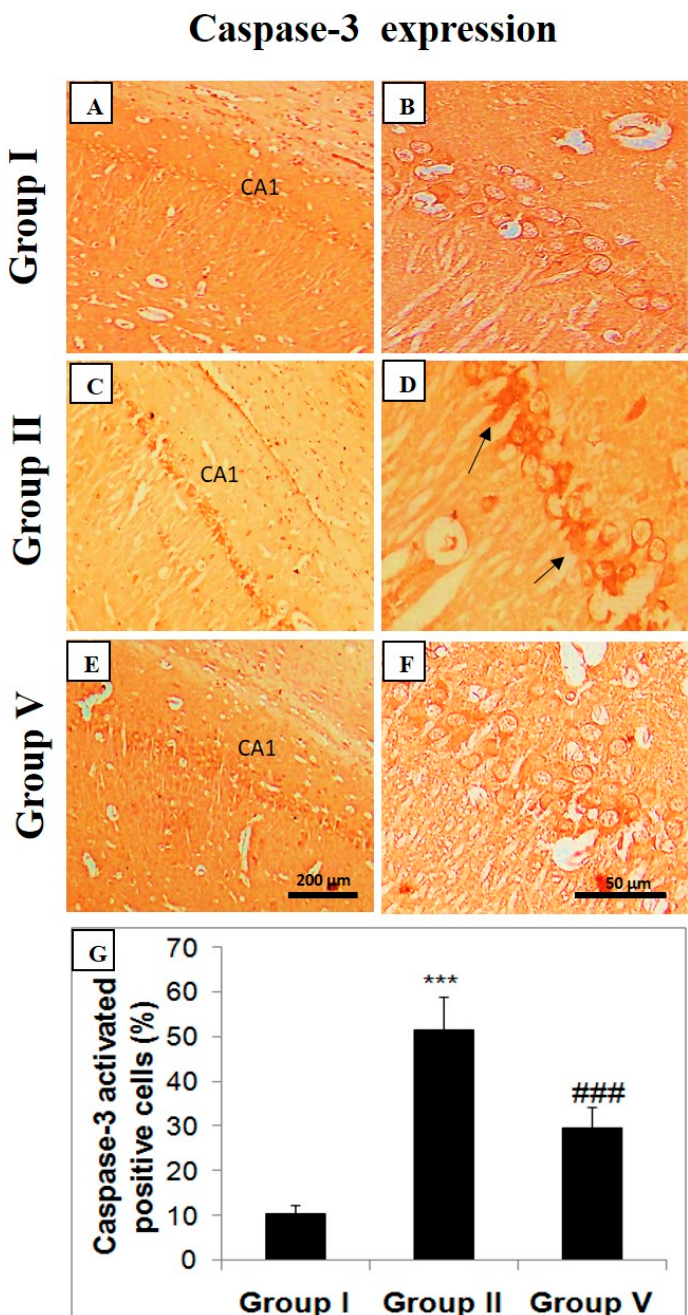
Figure 6. Zingerone downregulates caspase-3 expression in LiCl-and-pilocarpine-induced SE. Photomicrographs of hippocampus depicting immunohistochemical analyses. Below photomicrographs is the panel which shows quantitative evaluation of activated caspase-3 indicating specific immune positive staining of activated caspase-3 with brown color. Values are expressed as mean ± SEM ( n = 6). Significant differences were indicated by *** p < 0.001 when compared with group I and ( ### p < 0.001) when compared with group II. The CA1 section of hippocampus in LiCl and pilocarpine administered group-II ( C , D ) has enhanced caspase-3 immuno-positive staining as stipulated by brown color in comparison to negative control group (group I) ( A , B ). But zingerone treatment (50 mg/kg b.w.) in group V ( E , F ) decreased activated caspase-3 in comparison to positive control (group I) ( ### p < 0.001) ( G ). Group I: Normal saline (10 mL/kg b.w.), Group II: LiCl (3 mEq/kg b.w.) + pilocarpine (30 mg/kg b.w.), Group V: zingerone (50 mg/kg b.w.) + LiCl (3 mEq/kg b.w.) + pilocarpine (30 mg/kg